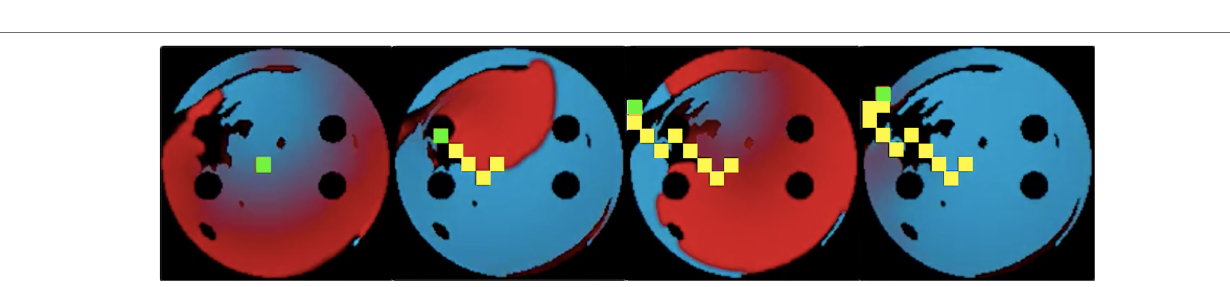
Figure 4B quantifies the tissue damage during ablation. As expected, the average number of ablated points in cases when AF was terminated successfully was lower than in the overall number of cases. The number of ablated points was about the same in training and testing.